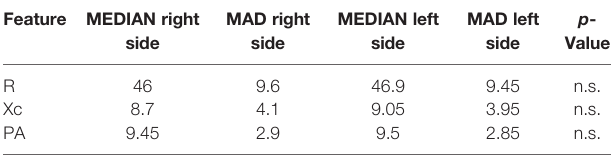
TABLE 3 | Median and MAD values of the bioimpedance features calculated on the right and left sides of the prostate in the right-sided prostate cancer group. PCa BPH Healthy Feature MEDIAN right MAD right controls side side